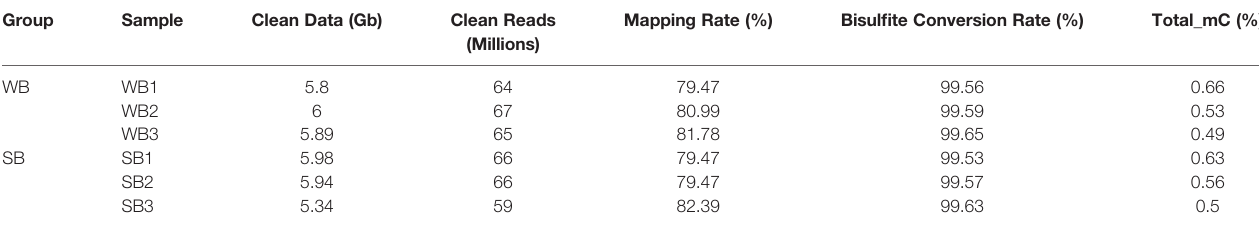
TABLE 1 | Whole genome DNA bisul fi te sequencing data. Group